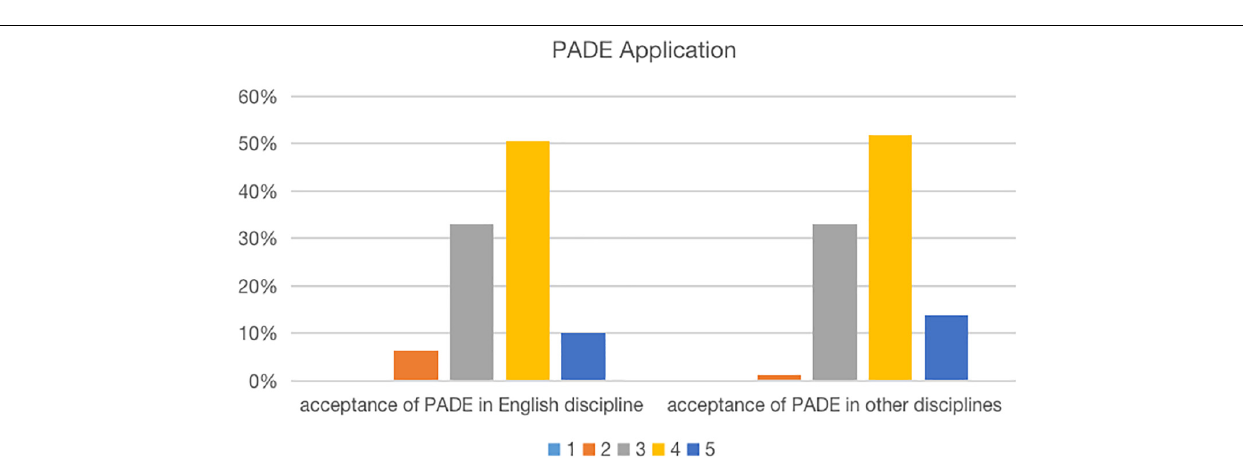
FIGURE 5 | Percentage of the PADE application: 1 – strongly disagree; 2 – disagree; 3 – neutral; 4 – agree; 5 – strongly agree.